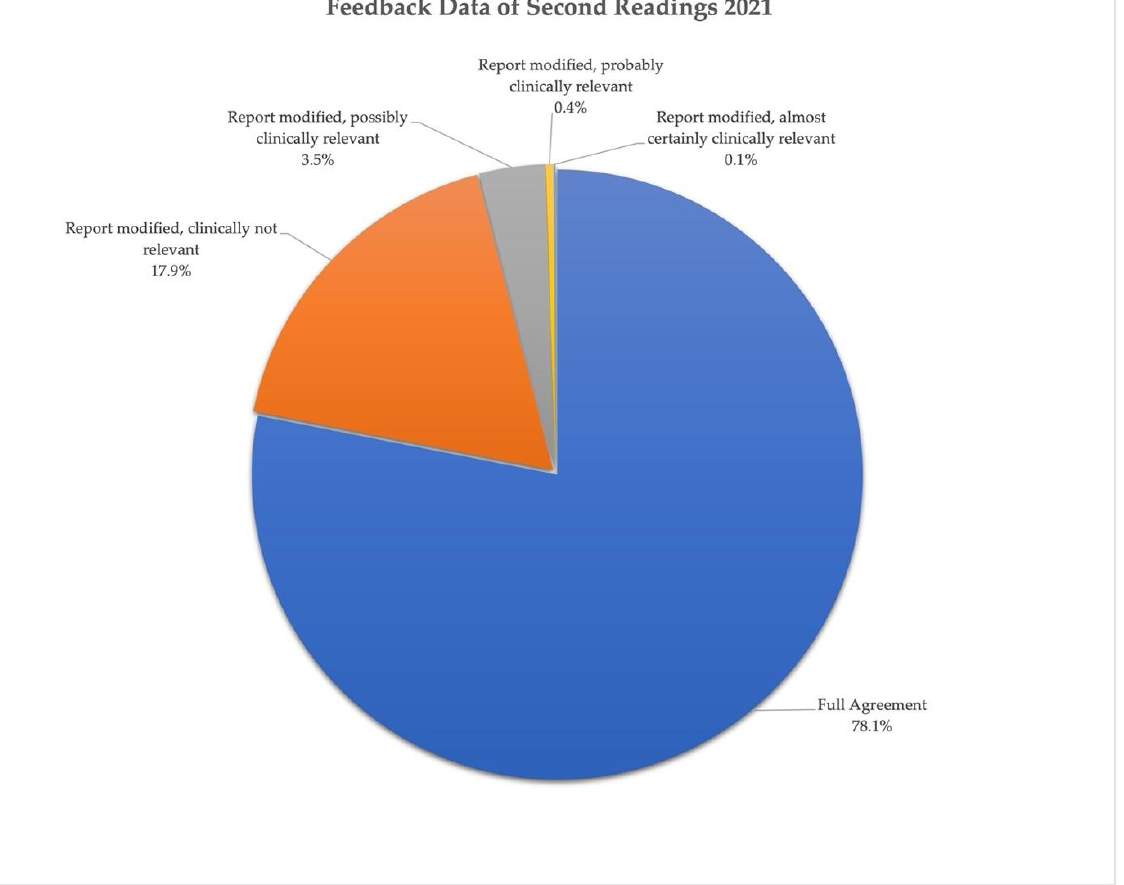
Figure 4. Feedback data of second readings for TMC’s elective sections in 2021.